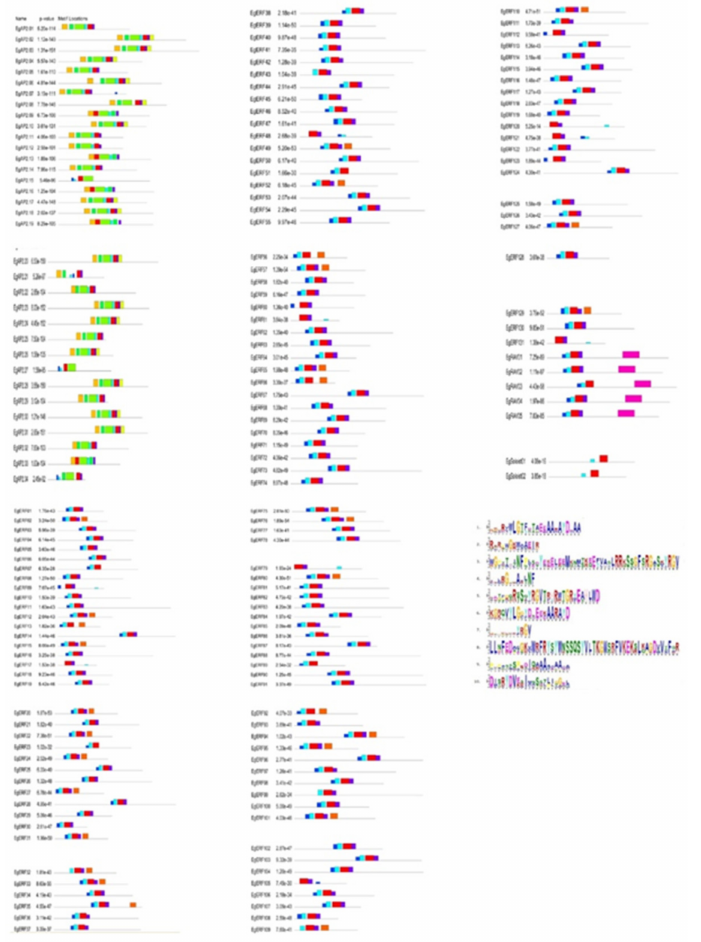
Figure 3. The architecture of conserved motifs in oil palm AP2/ERF proteins. Ten motifs were identified in AP2/ERF proteins using the MEME tool. Each motif in AP2/ERF proteins is represented with different colors. The abundance of each amino acid in every motif of oil palm AP2/ERF proteins is given in the sequence